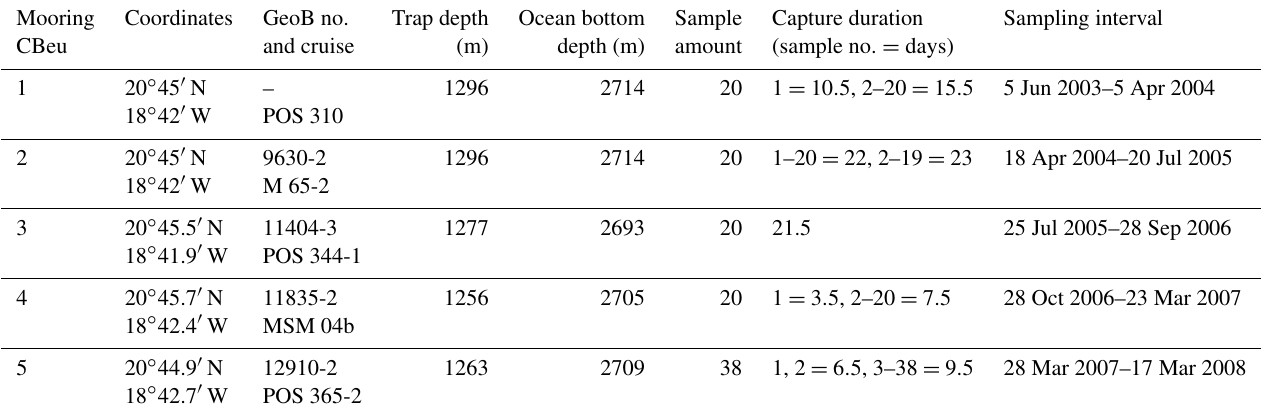
Table 1. Data deployment at site CBeu (Cap Blanc eutrophic, off Mauritania): coordinates, GeoB location and cruise, trap depth, ocean bottom depth, sample amount, capture duration of each sample, and sampling interval. Two gaps in the sampling intervals occurred: 5– 18 April 2004 and 28 September–28 October 2006. Mooring Coordinates GeoB no. Trap depth Ocean bottom Sample Capture duration Sampling interval CBeu and cruise (m) depth (m) amount (sample no. =